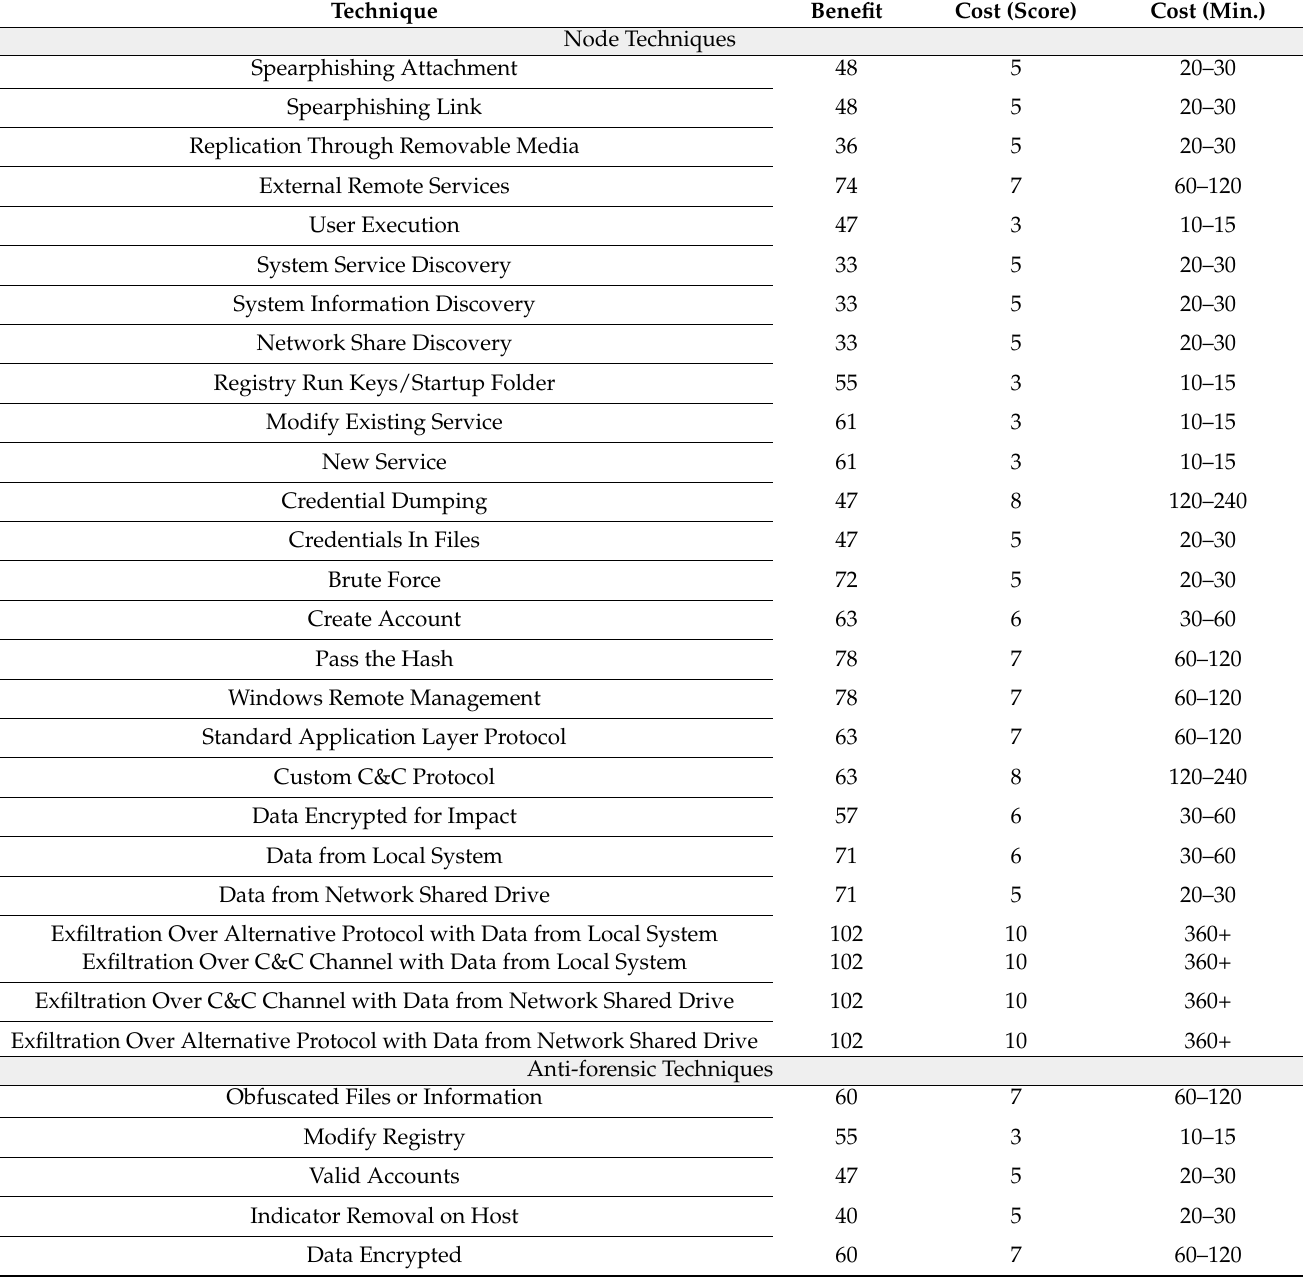
Table 6. Cost and benefit values for each Technique used in the case